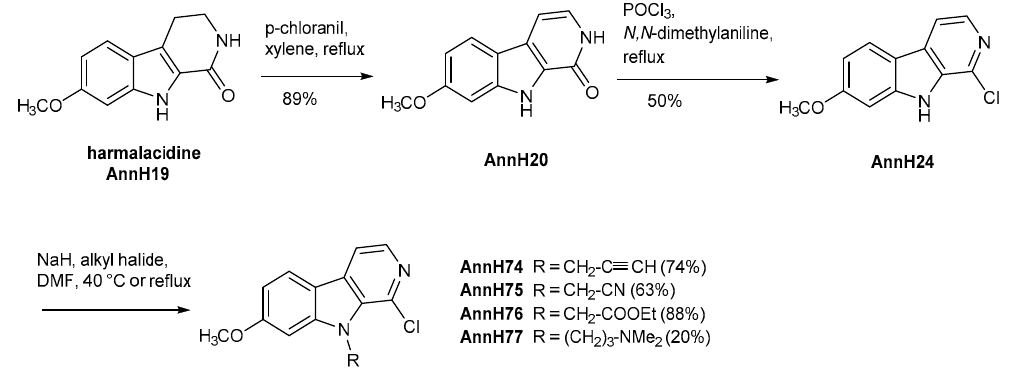
Scheme 4. Synthesis of harmine analogues modified at position C-1 and subsequent N -alkylations.